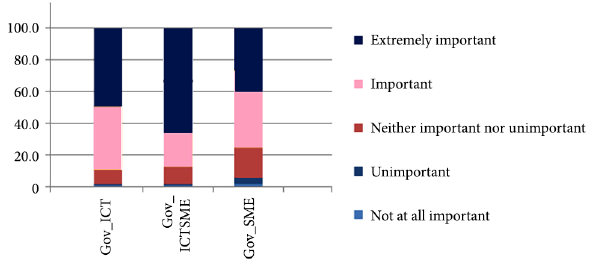
Figure 3. Respondents’ viewpoints regarding the variable government